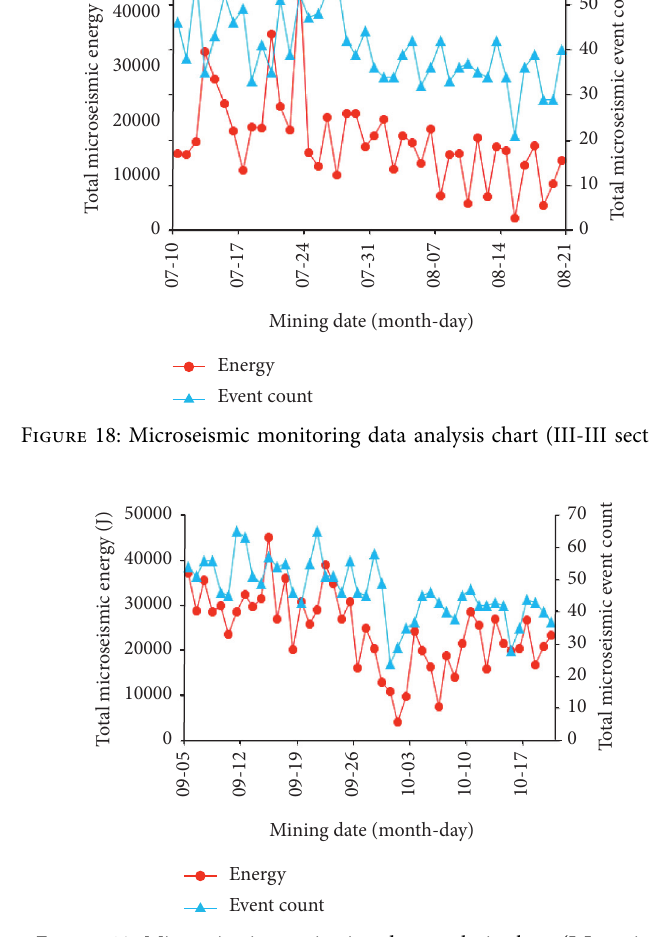
Figure 19: Microseismic monitoring data analysis chart (I-I Table 6: Relation between positive velocity anomalies and coal burst risk level.